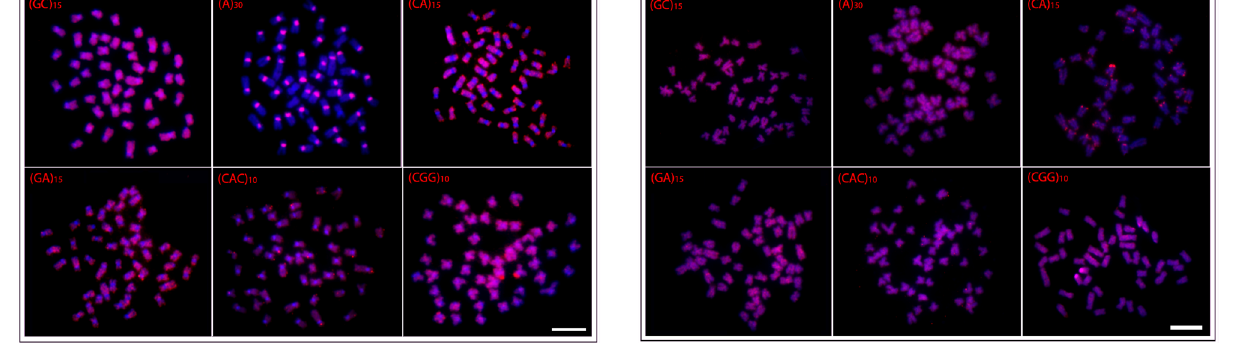
Figure 4 – Hybridization patterns with microsatellites probes (red signals) on metaphase plates of the Osteochilus melanopleura . Chromosomes were counterstained with DAPI (blue). Scale bar = 5 μm.